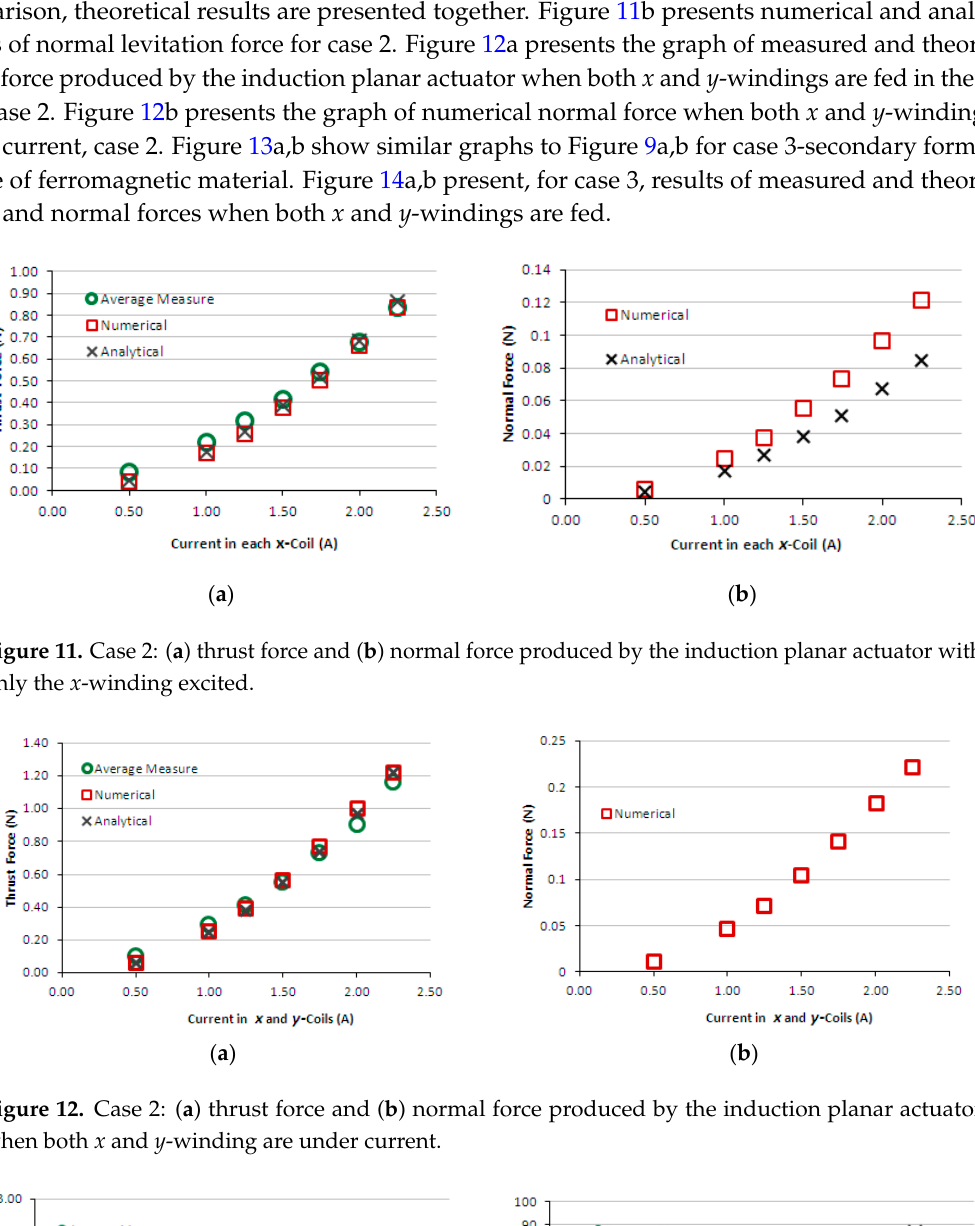
Figure 10. Case 1: ( a ) thrust force and ( b ) normal force produced by the induction planar actuator when both x and y -winding are under current.